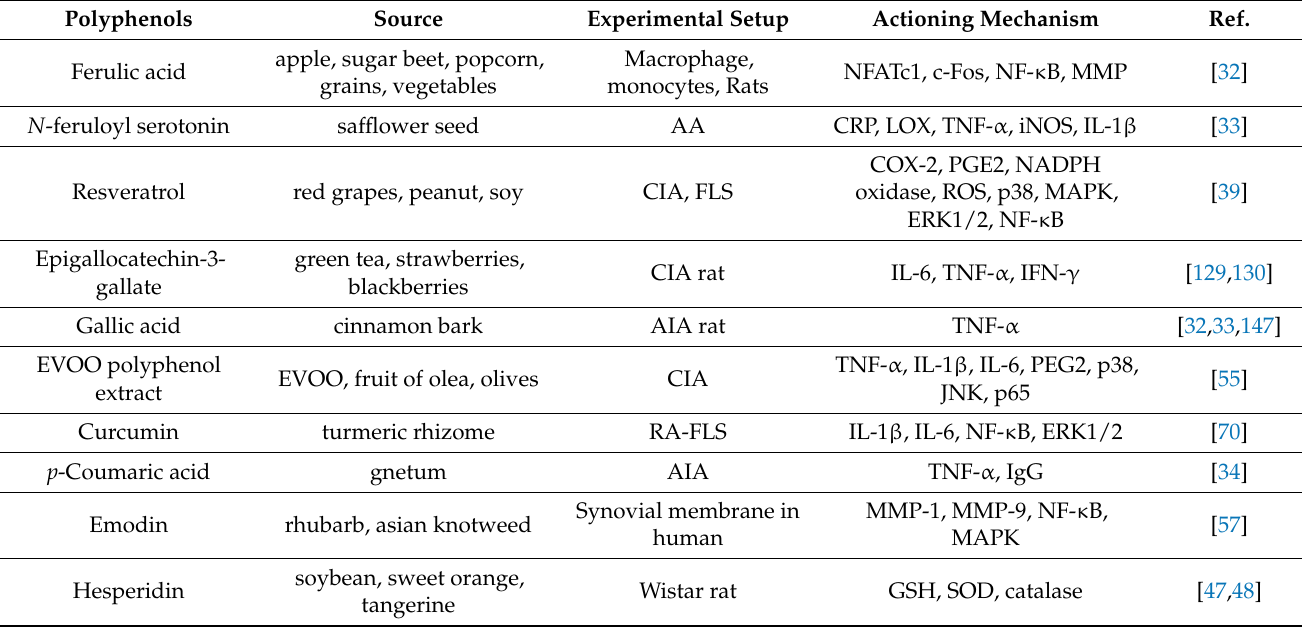
Table 1. Rheumatoid arthritis-inhibiting phenolic acid, stilbenes, flavonoids, and other polyphenols.